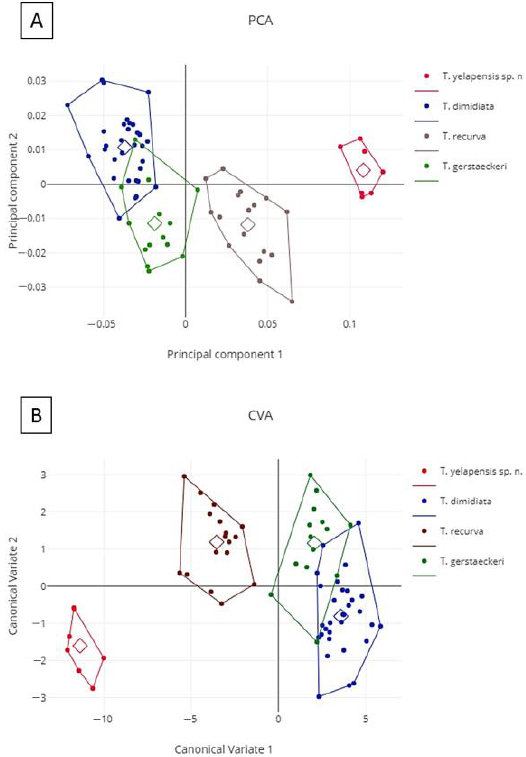
Figure 8. ( A ) Principal component (PCA) and ( B ) canonical variate (CVA) analyses of the factorial maps of the head shape for male and female specimens of Triatoma yelapensis n. sp., T. dimidiata, T. gerstaeckeri , and T. recurva.